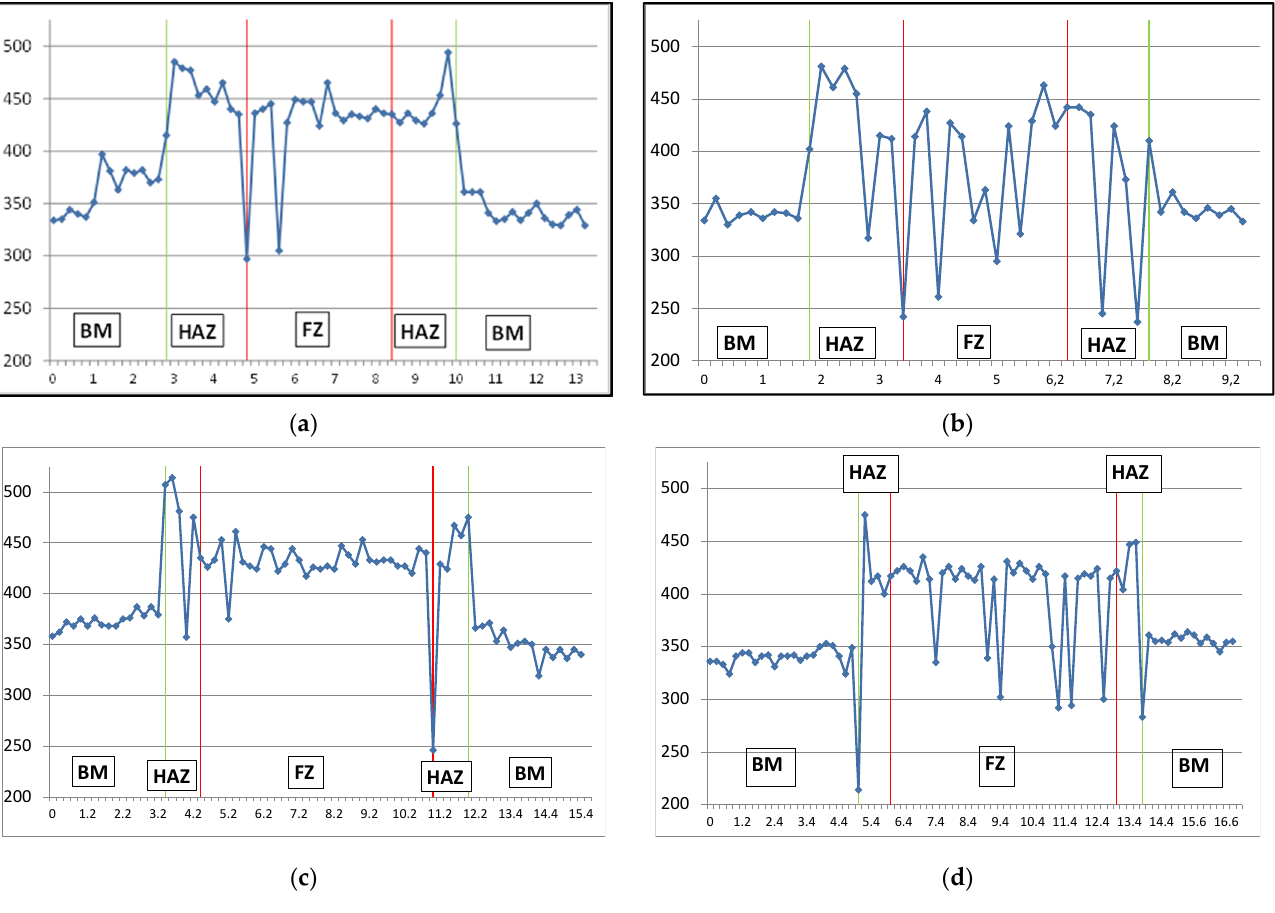
Figure 12. Longitudinal line HV t = 420 ms: ( a ) D min f = 1000 Hz, ( c ) D Proy f = 1000 Hz; ( b ) D min f = 7000 Hz, ( d ) D Proy f = 7000 Hz.